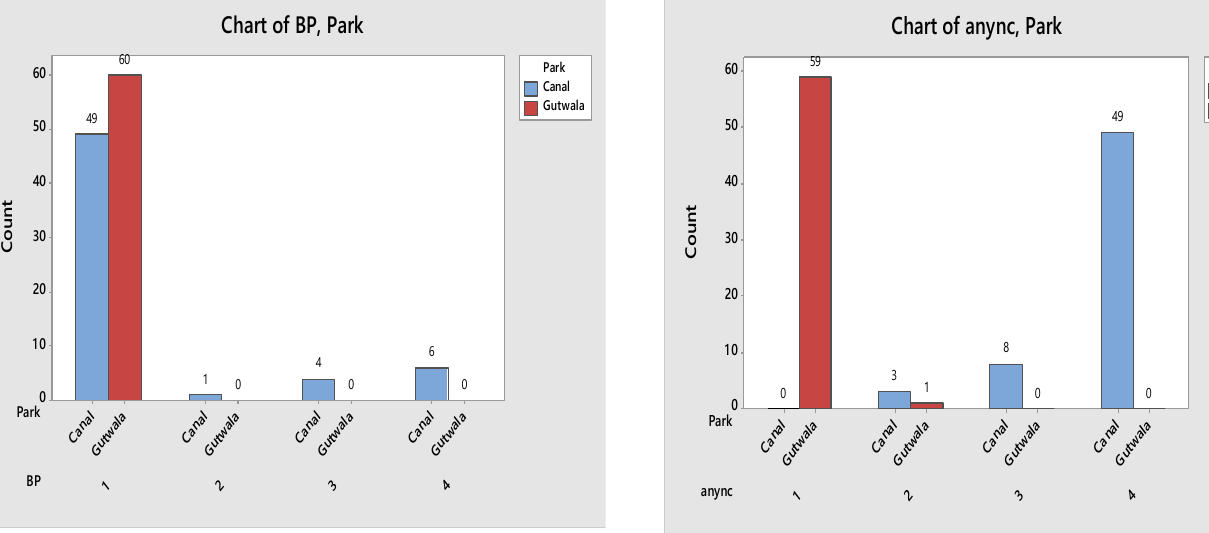
Figure 12: Bar Chart of Annoyance problem between both sites Similarly, for annoyance depicted in fig. 12 showed that 49 out of 60 visitors responded highly affected by the annoyance due to noise pollution 8 out 60 showed mild and 3 out of 60 showed low response in the site-1 Canal Park, contrarily, 59 out of 60 visitors in the Site-2 Gat Wala Park did not show any symptom of annoyance due to noise pollution while 1 out of 60 showed low response, which mean the mostly response observed in this regard was nil (Annoyance) and confirming that the environment of the Gat Wala Park is peaceful and calm while environment of the Canal Park is noisy and affecting health of the visitors.